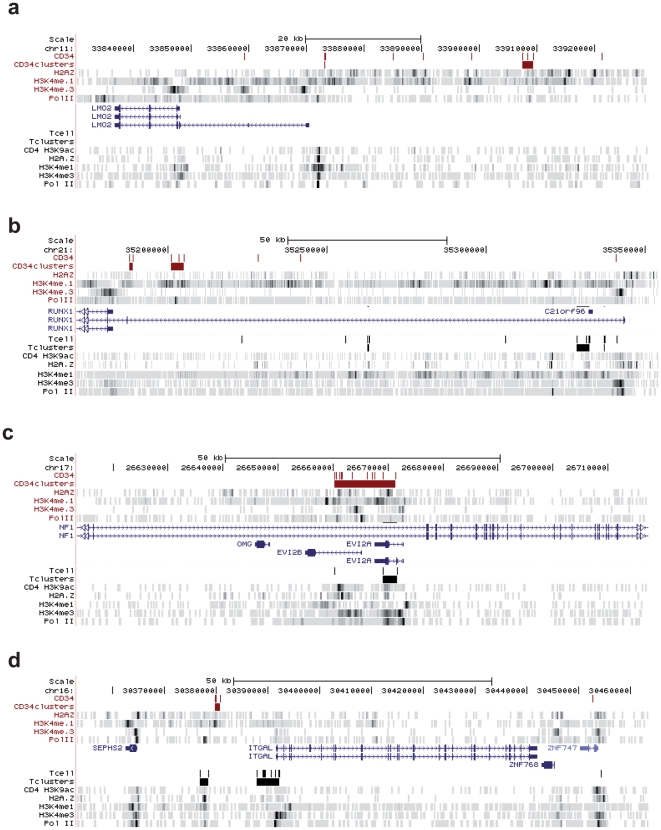
MLV integration clusters in CD34+ HPC-specific loci.Distribution of MLV integrations and clusters within three RefSeq gene loci expressed in both T cells and CD34+ cells (RUNX1, EVI2A/B, ITGAL) or only in CD34+ HPCs (LMO2), as displayed by the UCSC genome browser. See legend of Figure 3 for explanation of symbols.